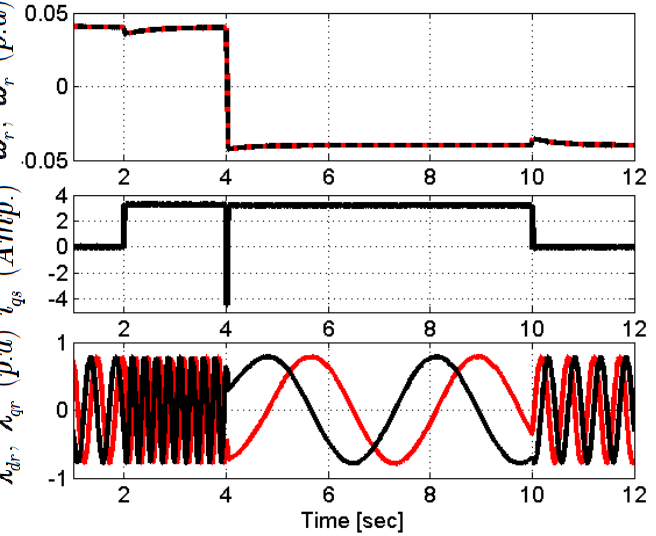
Figure 15. Simulation tests at a speed reference of 0.04 p.u (6.28 rad/s) was changed − 0.04 p.u ( − 6.28 rad/s) with a rated T L change of +7 N.m applied at t = 2 s and removed t = 10 s.